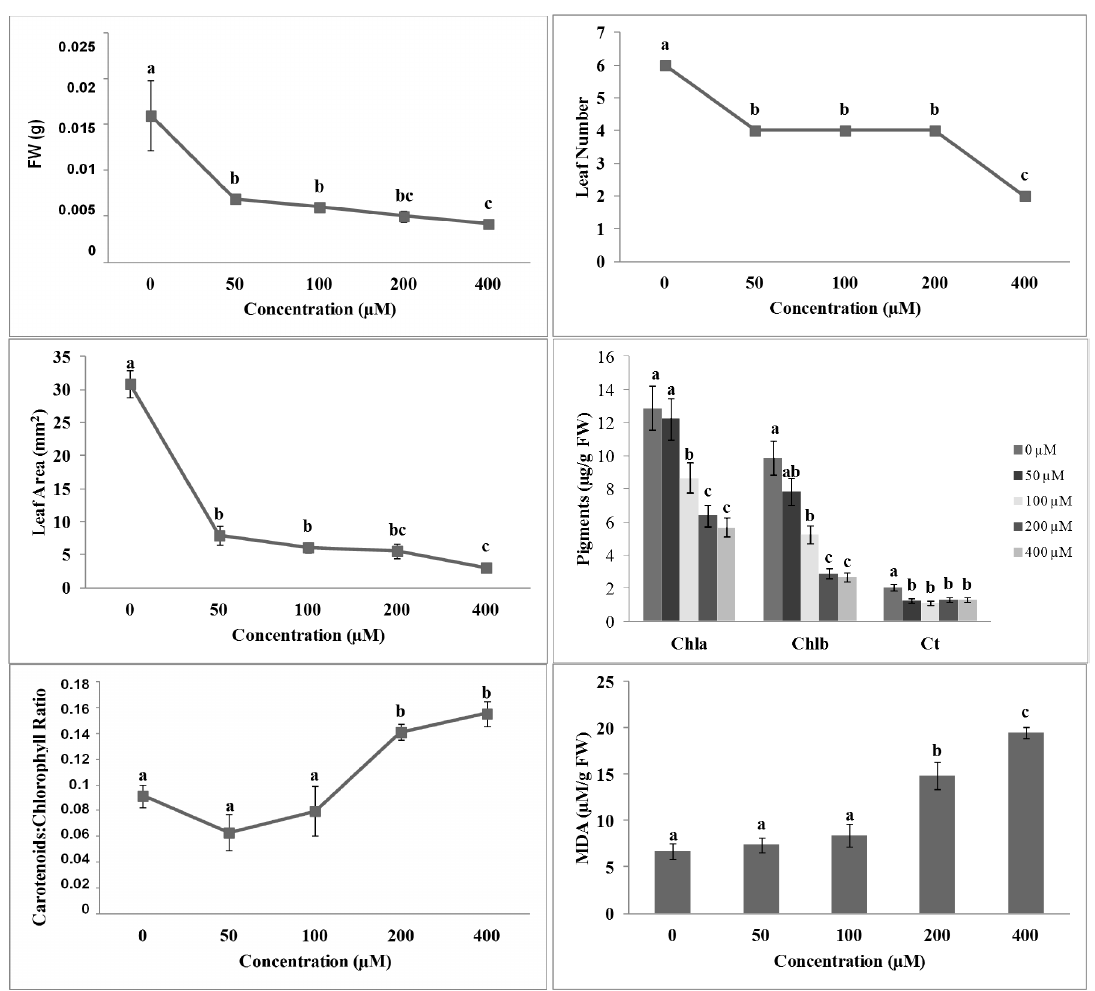
Figure 1. Morpho-physiological parameters of A. thaliana seedlings treated with different concentrations of compound 1 : Shoot Fresh Weight (SFW), Leaf Number (LN), Leaf Area (LA), pigments content, Carotenoids:Chlorophyll Ratio and MDA content. Different letters along the curves indicate significant differences at p ≤ 0.05. All data were analyzed by ANOVA, applying Tukey’s and Tamhane’s T2 tests for homoscedastic and heteroscedastic parameters, respectively ( N =